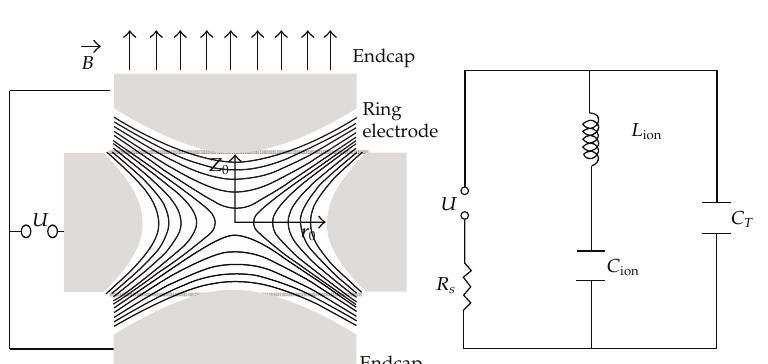
Figure 1: (cid:3) right (cid:4) Longitudinal projection of a hyperbolical Penning trap with cylindrical symmetry along the z -axis. U is the DC potential applied to the endcaps with respect to the ring. Due to the shape of the electrodes, the equipotential lines are hyperboloids of revolution. r 0 and z 0 give the characteristics √ 2 z 0 . (cid:3) left (cid:4) Equivalent circuit of the Penning dimensions of the Penning trap and are related by r 0 (cid:7) trap with one stored ion. The ion can be described as an inductance (cid:3) L ion (cid:7) m (cid:3) 2 z 0 (cid:4) 2 /q 2 (cid:4) in series with a capacitor (cid:3) C ion (cid:7) 1 / (cid:3) ω 2 L ion (cid:4)(cid:4) . C T gathers all the capacitances between the trap electrodes or between the electrodes and ground. R s is the internal resistance of the power